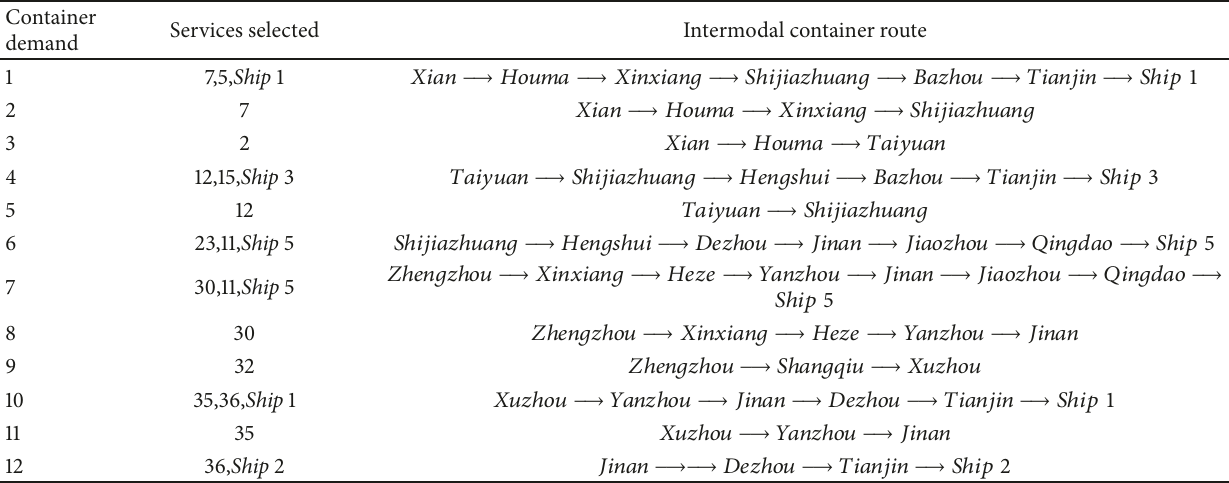
Table 6: The service and route choice of the stochastic